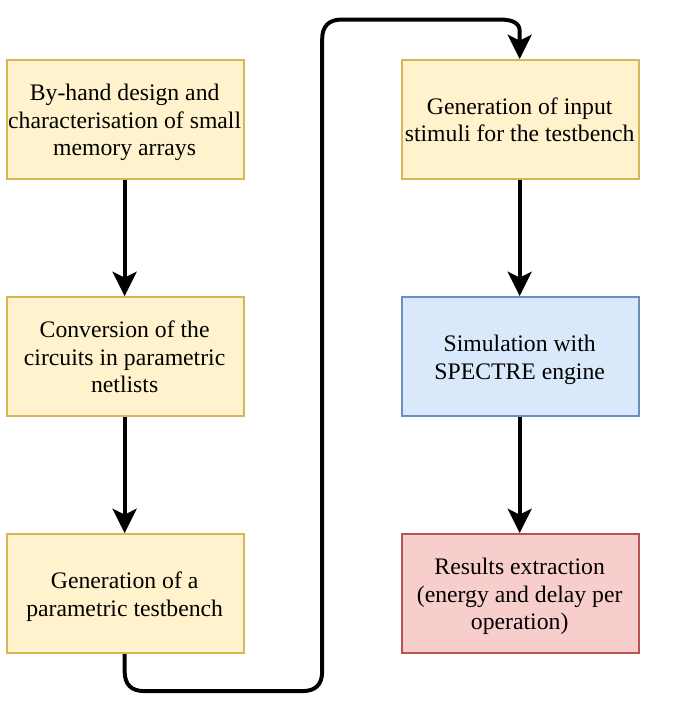
Figure 17. The simulation flow. Starting from the by-hand designed circuits of small arrays, the sim- ulation of large ones is achieved through the algorithm shown in the figure.